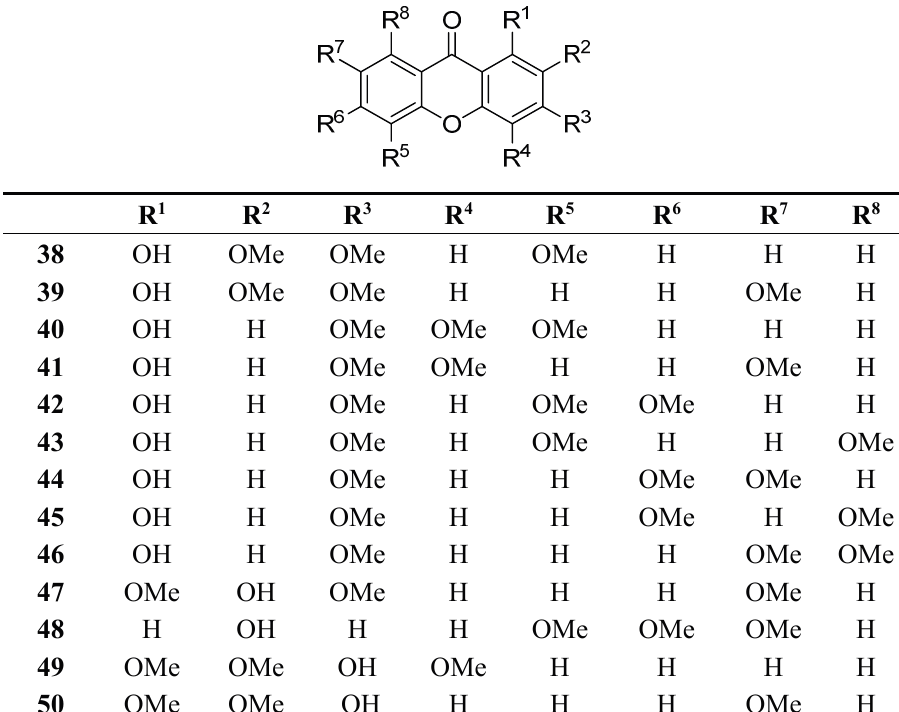
Figure 3. Chemical structures of tested trioxygenated